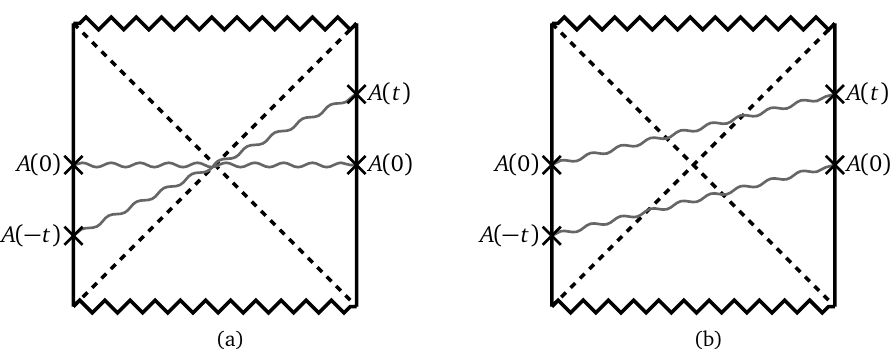
Figure 2: The two contractions that contribute to the connected correlation function. The contraction (a) is time independent, the contraction (b) decays exponentially in